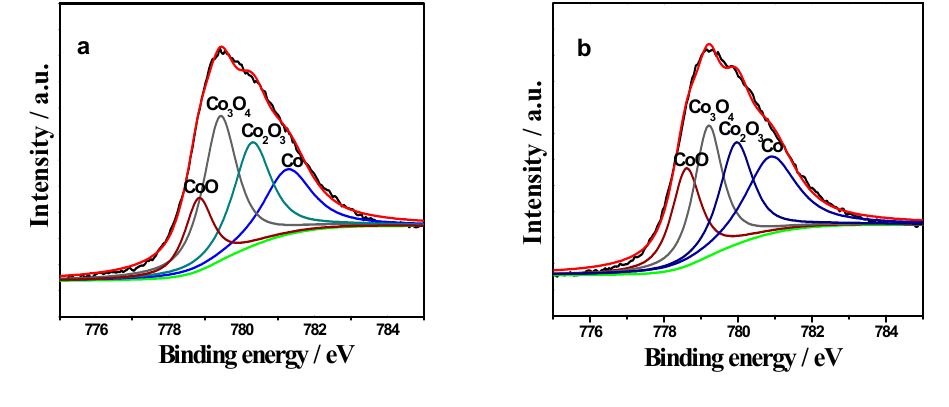
Table 2. XPS surface atomic